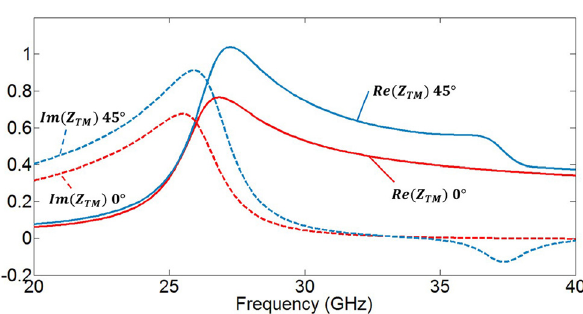
Figure5: Effectivetangentialpermittivityand permeability of the meta-glass structure for normally incident waves.